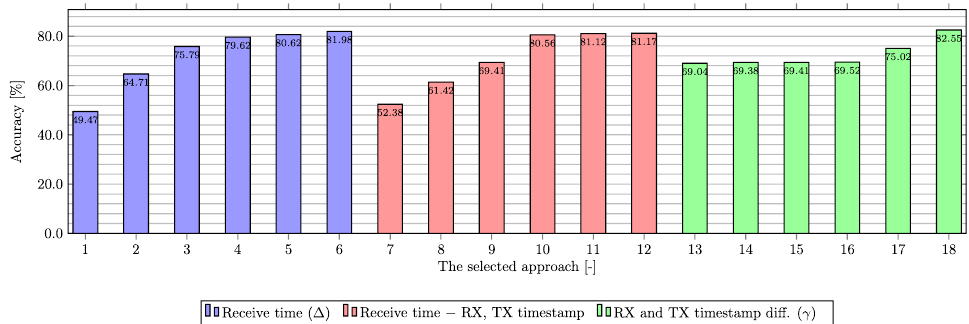
Figure 6. Comparison of achieved results using DNN approaches based on the testing